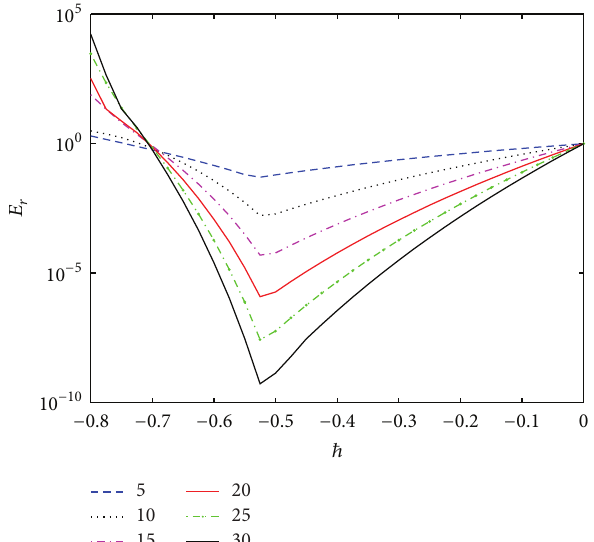
Figure 1: Residual error curve for locating optimal ℎ when 𝜉 = 0.98 for 𝑀 = 5, 10,15, 20, 25, 30 .